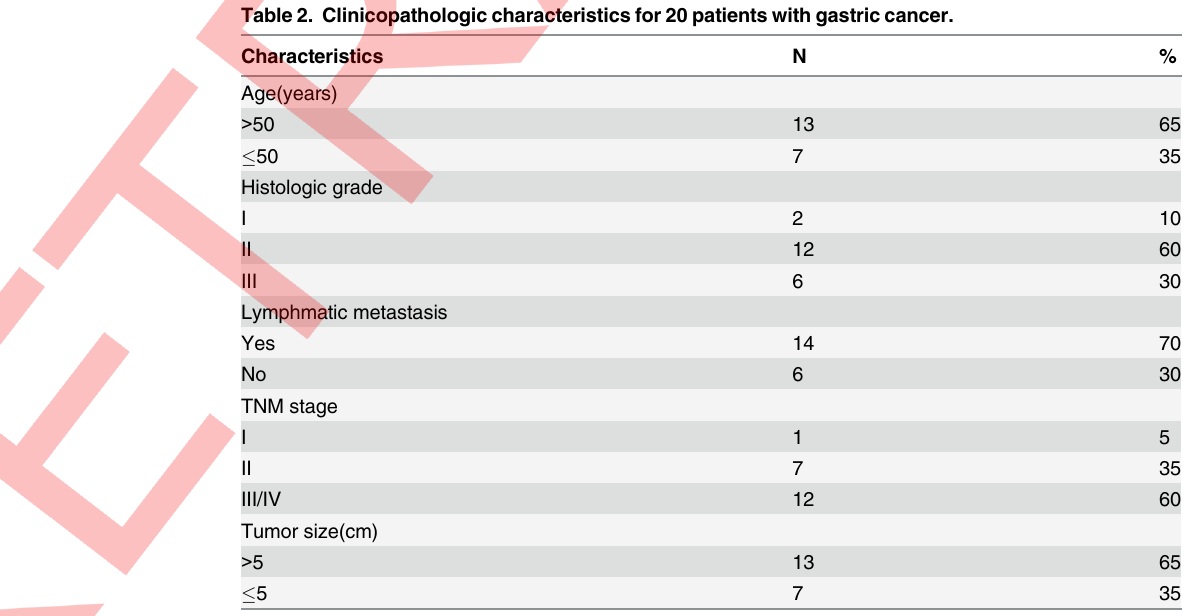
Table 2. Clinicopathologic characteristics for 20 patients with gastric